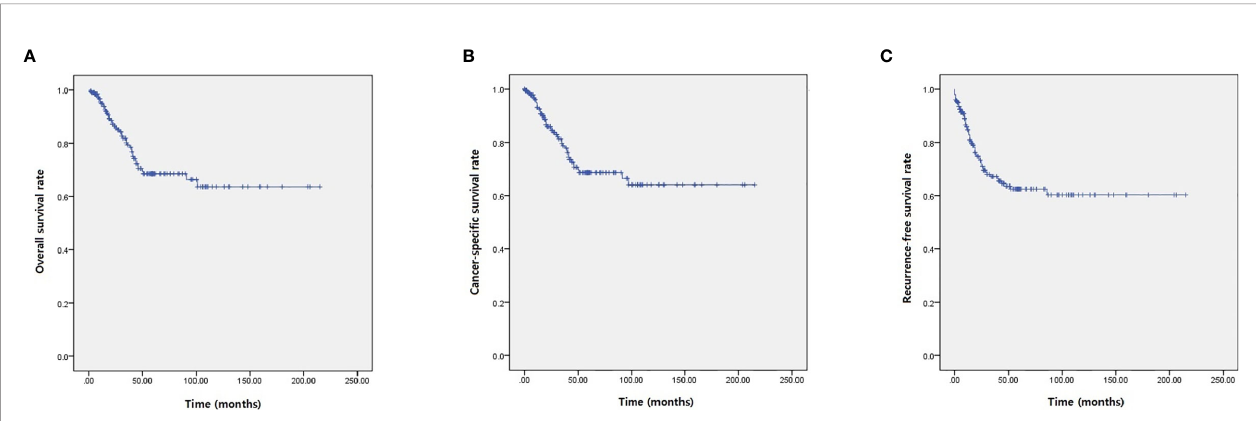
FIGURE 1 | Kaplan – Meier analyses presenting survival outcomes of UC patients. (A) OS. (B) CSS. (C)